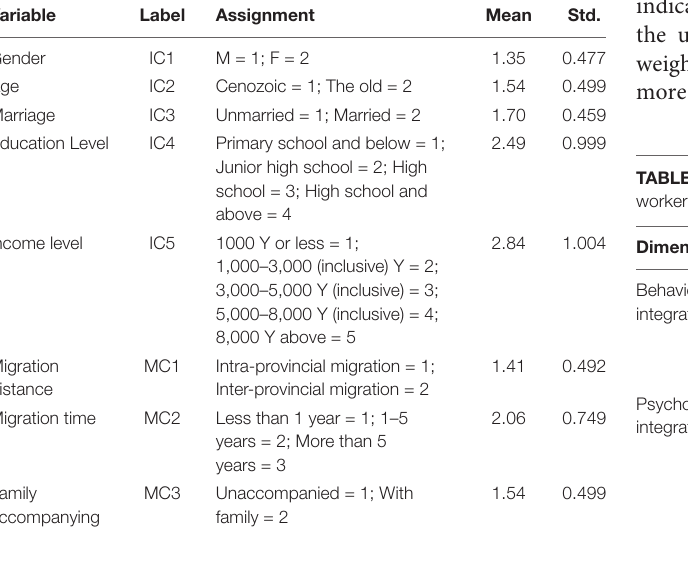
TABLE 2 | Variable definitions and descriptive statistics.